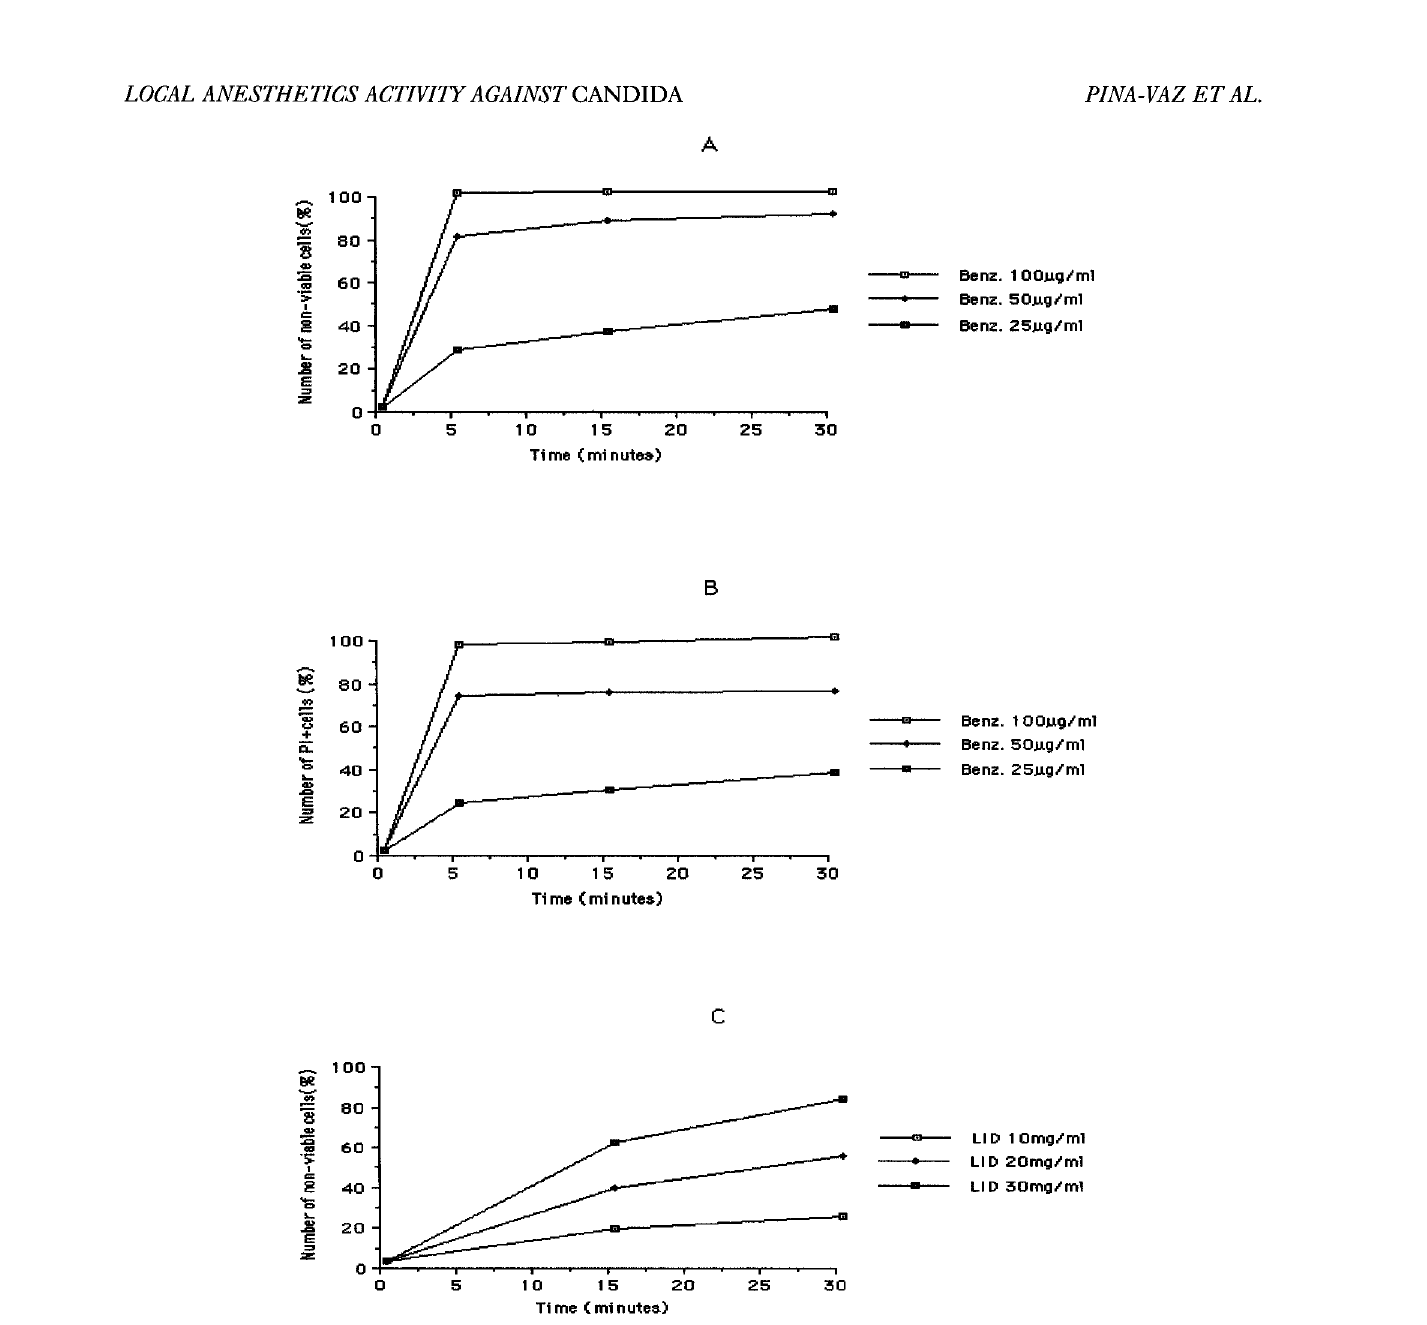
Fig. 2. Percentage of unviable (A, C, E) and Pl-positive, (B, D, F) C. albicans, ATCC strain 10231 cells exposed for 30 rain to increasing concentrations of benzydamine (benz.) (A, B), lidocaine (LID) (C, D) or bupivacaine (BUP) (E, F). processing were used. Biochemically active cells, stained with this fluorescent membrane-permeable dye, exhibit under fluorescence microscopy or- ange/red cylindrical intravacuolar structures (CIVS), while nonviable cells or viable cells with severely impaired metabolism do not show these structures. 11 Metabolically impaired yeast cells show an increased intracellular accumulation of the probe, which can be detected by flow cytometry, lz Untreated and treated yeast suspensions in GH